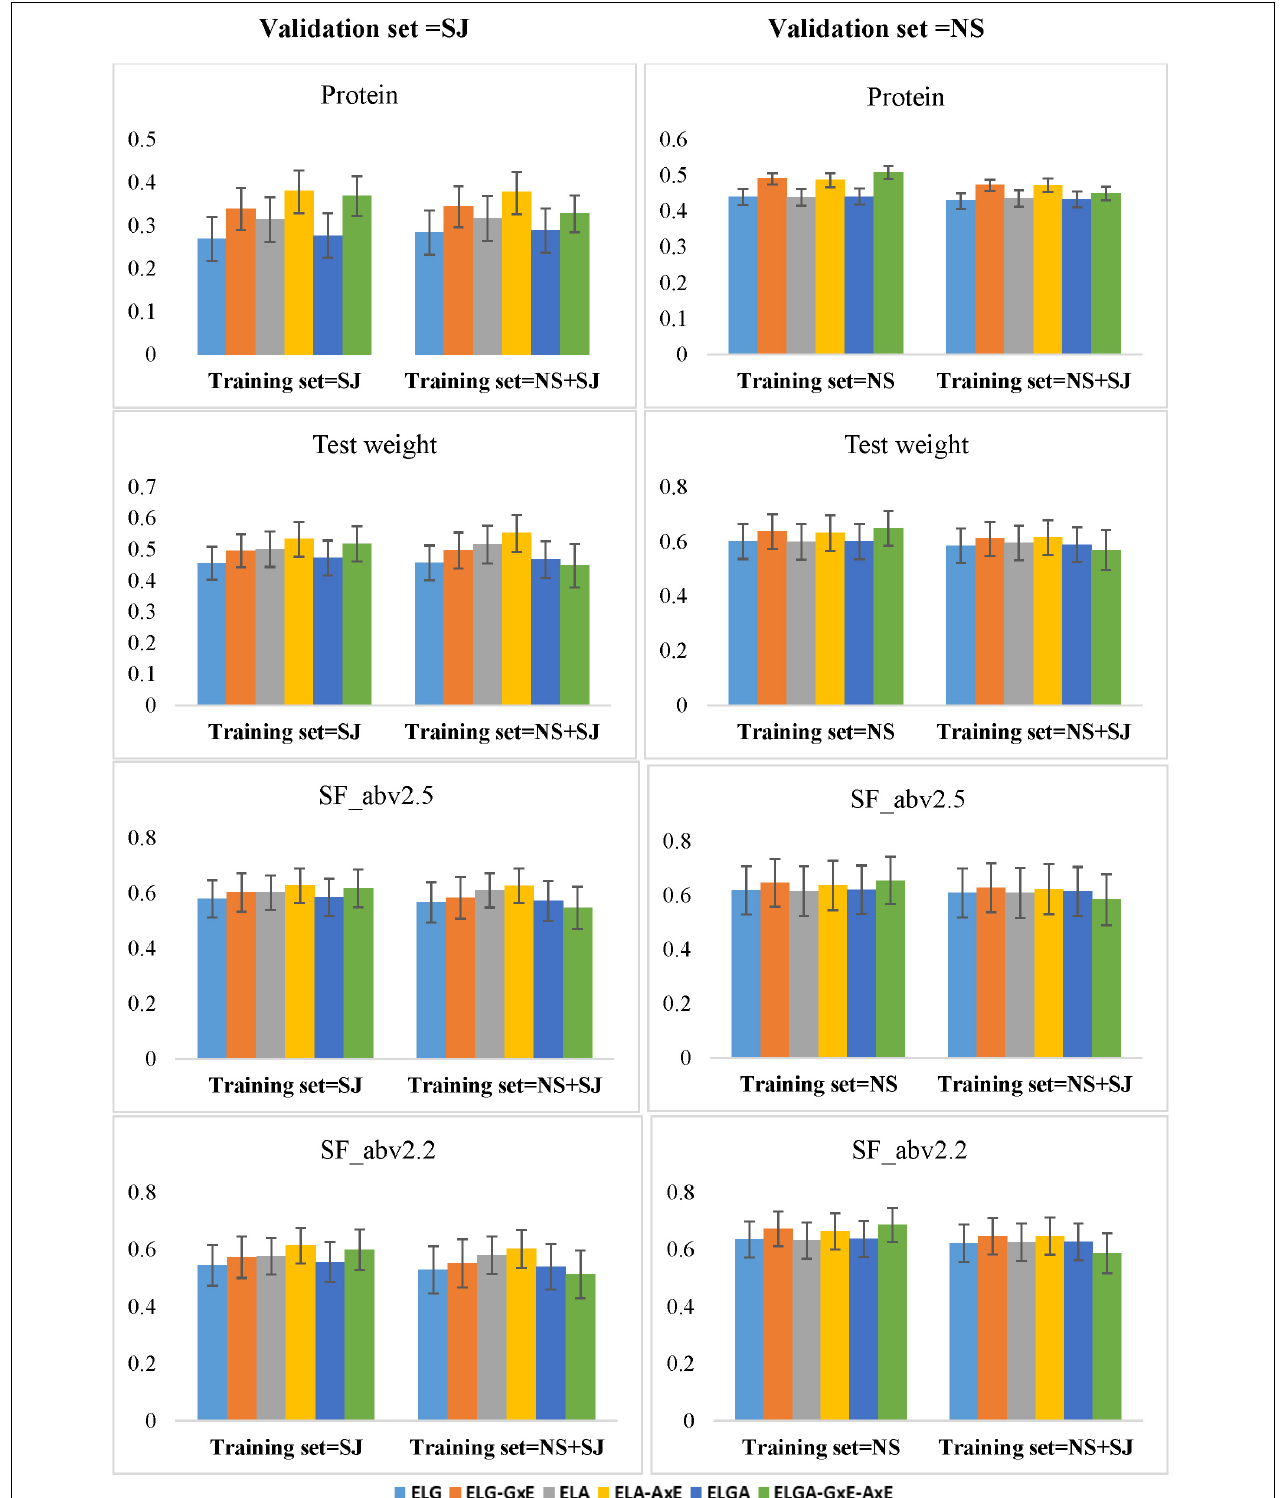
FIGURE 5 | Prediction abilities ( y -axis) obtained when the training set is composed of lines from either one breeding program or combined breeding programs. Using the CV1 scheme (predicting newly developed lines in known environments), all six models were compared for all the traits. The x -axis displays different training sets. For the left panels (Validation set = SJ), N = 392 for SJ training set and N = 826 for NS + SJ training set. For the right panels (Validation set = NS), N = 438 for NS training set, and N = 826 for NS + SJ training set. Error bars depict the standard error from the mean of the 10 fold correlations.